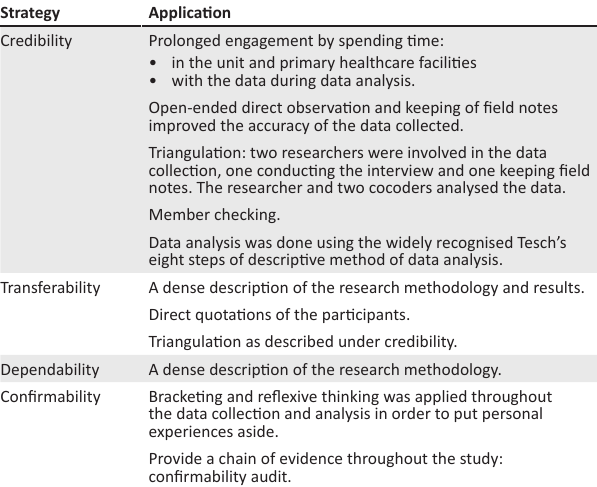
TABLE 2: Results: Theme 1, categories and subcategories: Impact of childhood atopic